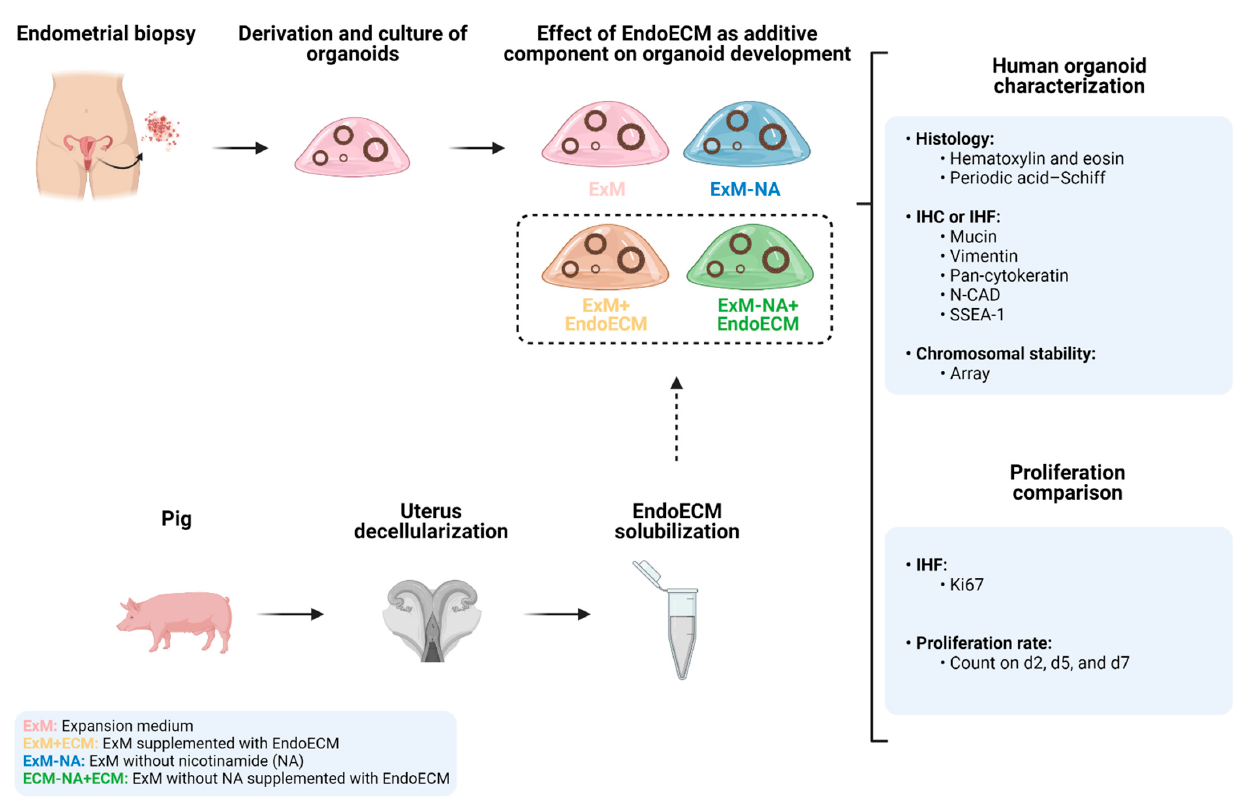
Figure 1. Experimental design. Human endometrial organoids were cultured under four different experimental conditions (ExM, ExM+EndoECM, ExM-NA, ExM-NA+EndoECM) and evaluated microscopically, histologically, immunohistochemically, and for chromosomal stability. Abbreviations: EndoECM, endometrial extracellular matrix; IHC: immunohistochemistry; IHF: immunohistofluorescence; N-CAD: N-cadherin; SSEA-1: stage-specific embryonic antigen-1; ExM: expansion medium; NA; nicotinamide. Created with BioRender.com.